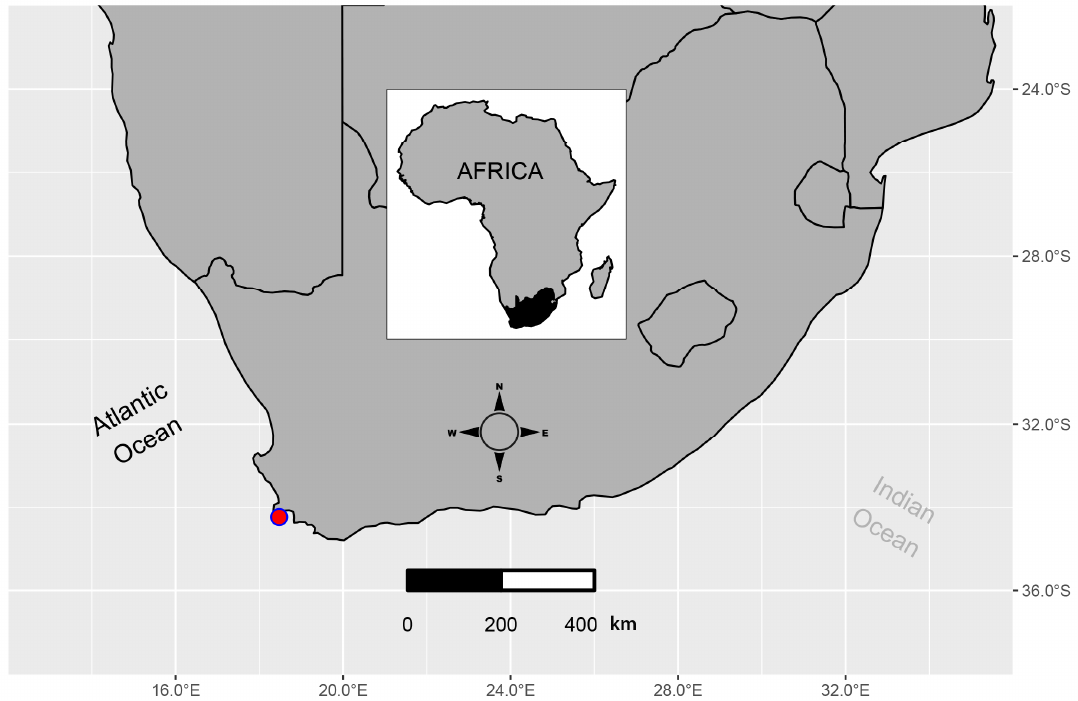
Figure 1. Map of South Africa showing the location of Miller´s Point, False Bay, South Africa (red